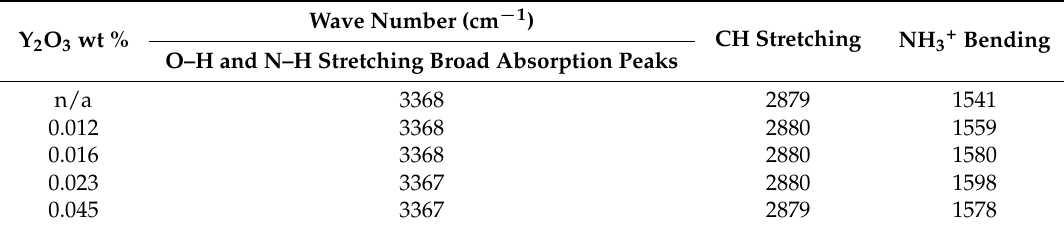
Figure 7. ( a ) FTIR spectra of the blended Y 2 O 3 /chitosan thin films; ( b ) Schematic diagram of hydrogen bonding between the Y 2 O 3 nanoparticles and the amine group of chitosan. Table 1. FTIR spectra analysis of the blended Y 2 O 3 /chitosan thin film.